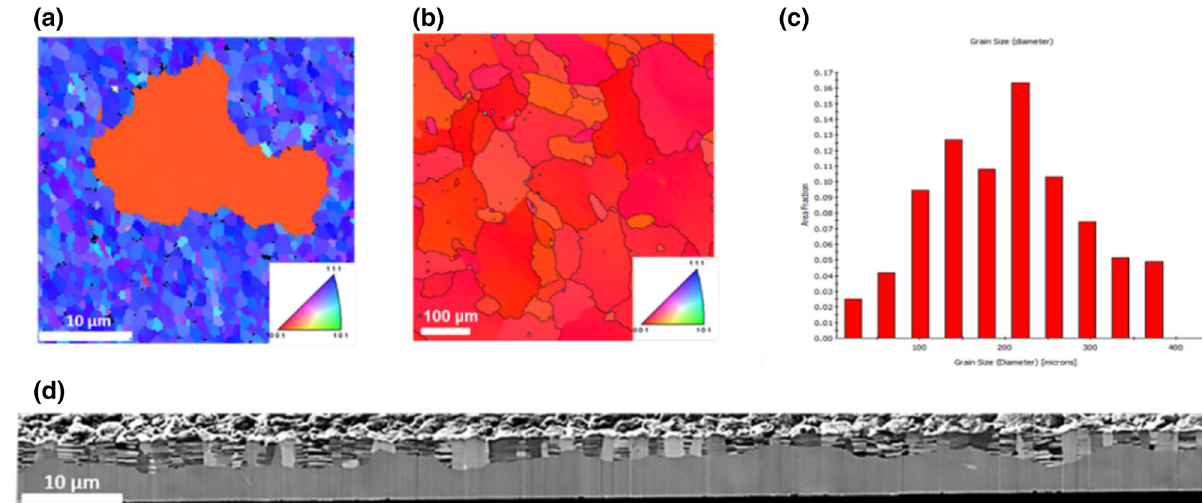
Figure 1. The uni-modal distribution of very large grains in 7 μm thick nt-Cu. ( a ) After annealing at 400 °C for 5 min, a large (200) grain grew in the matrix of small (111) grains. ( b ) Plan-view EBSD showing large (100) grains after 400 °C for 1 h. ( c ) Distribution of grains size in ( b ). ( d ) Cross-sectional FIB image revealing the anisotropic grain growth in the nt-Cu film. A large (100) grain grew at the bottom of the nt-Cu